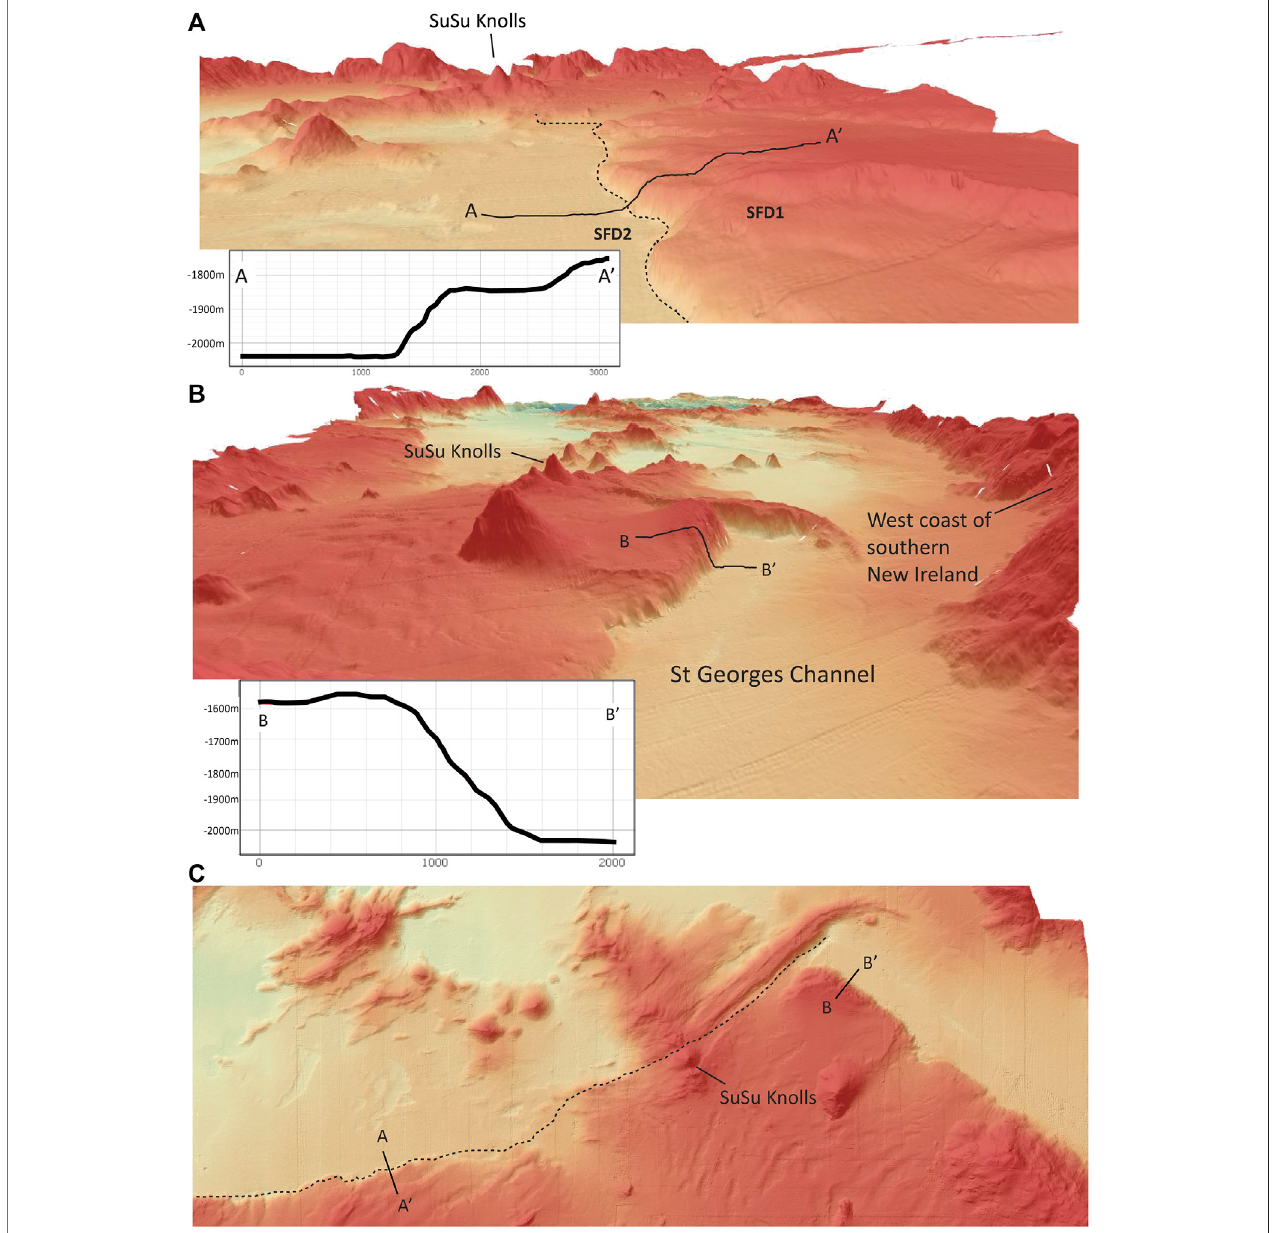
FIGURE9| 3DTransectsacrossSFD1toSFD2aroundtheSuSuKnollsarea. (A) showstheboundarybetweenSFD1andSFD2westoftheSuSuKnolls,looking to the southeast. The SuSu Knolls are in the top left of the fi gure. Inset is a pro fi le and highlights the steep scarp that de fi nes the boundary. Vertical exaggeration is 2.5x. (B) 3DviewoftheStGeorgesChannelhighlightingthefault scarpalongtheWeitinFaulttrace.Image is2.5xexaggerated and viewedtothenorthwest. Interpretedtrace of the left lateral Weitin Fault lies at the base of the scarp. (C) Plan view showing the transects in (A,B) . Images and pro fi les were generated using QGIS (QGIS,